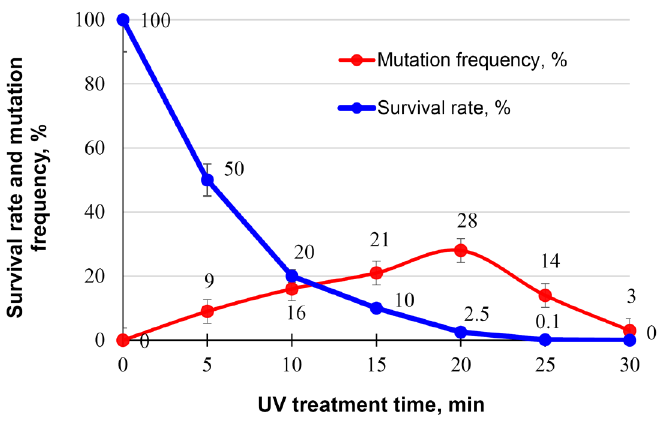
Figure 2. Effect of the UV exposure time on the survival rate and morphological mutation frequency of Penicillium chrysogenum VKPM F-1310.